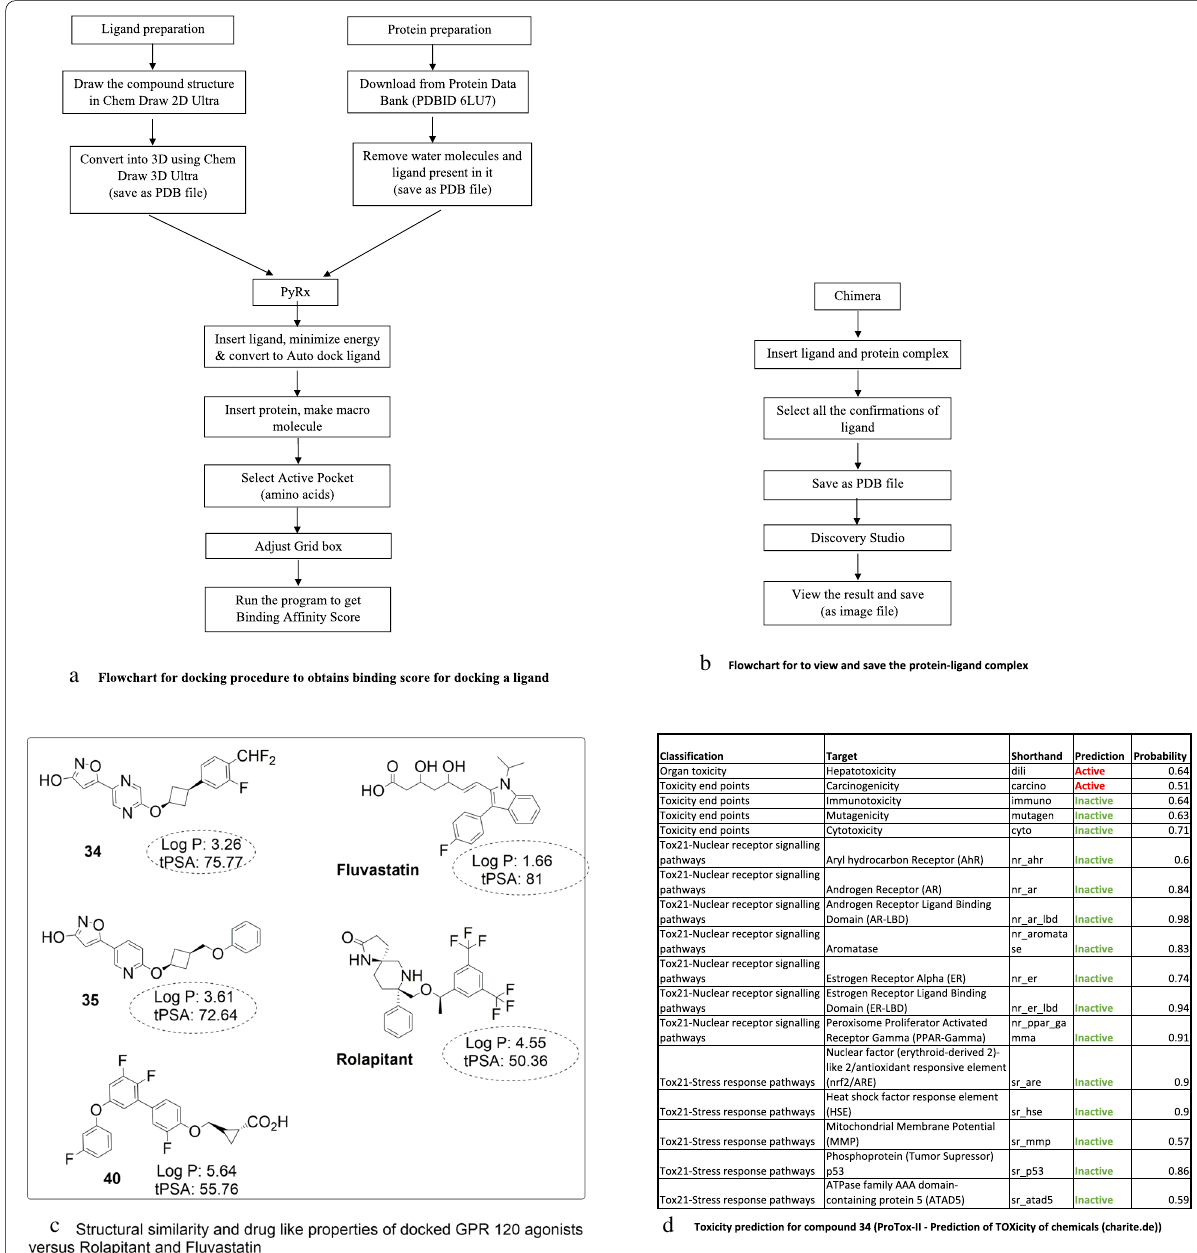
Fig. 2 a Flowchart for docking procedure to obtain binding score for docking a ligand. b Flowchart for to view and save the protein-ligand complex. c Structural similarity and drug like properties of docked GPR 120 agonists versus Rolapitant and Fluvastatin . d Toxicity prediction for compound 34 (ProTox- II - Predi ction of TOXic ity of chemi cals (chari te.